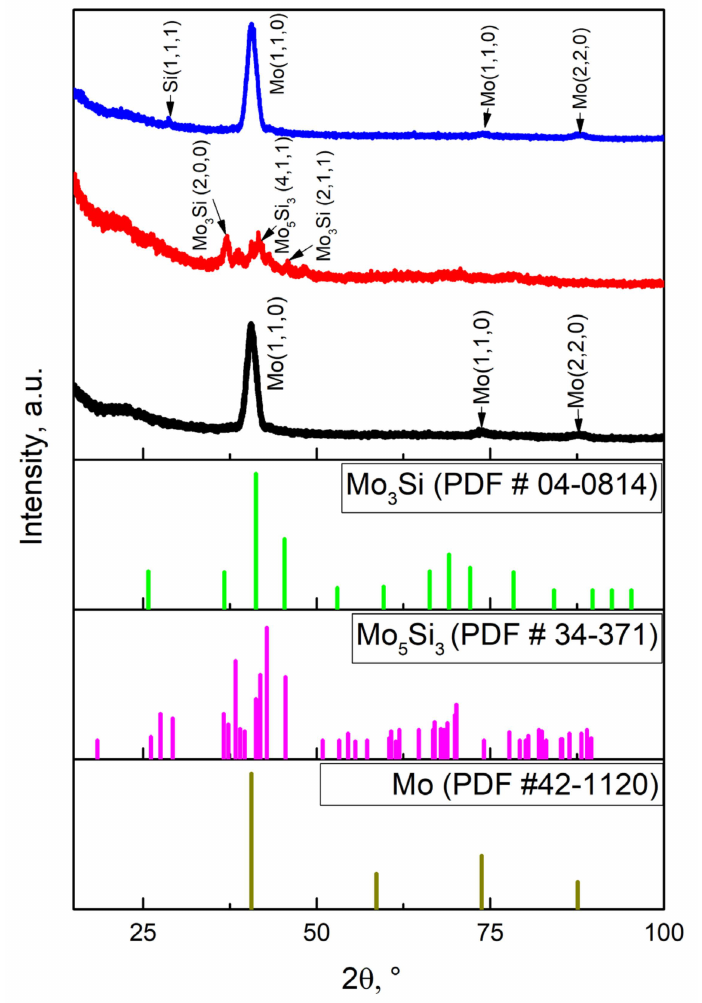
Figure 8. XRD patterns of coatings: original (black), irradiated in air (blue) and irradiated in neon (red). Reference patterns for Mo and molybdenum silicides are shown